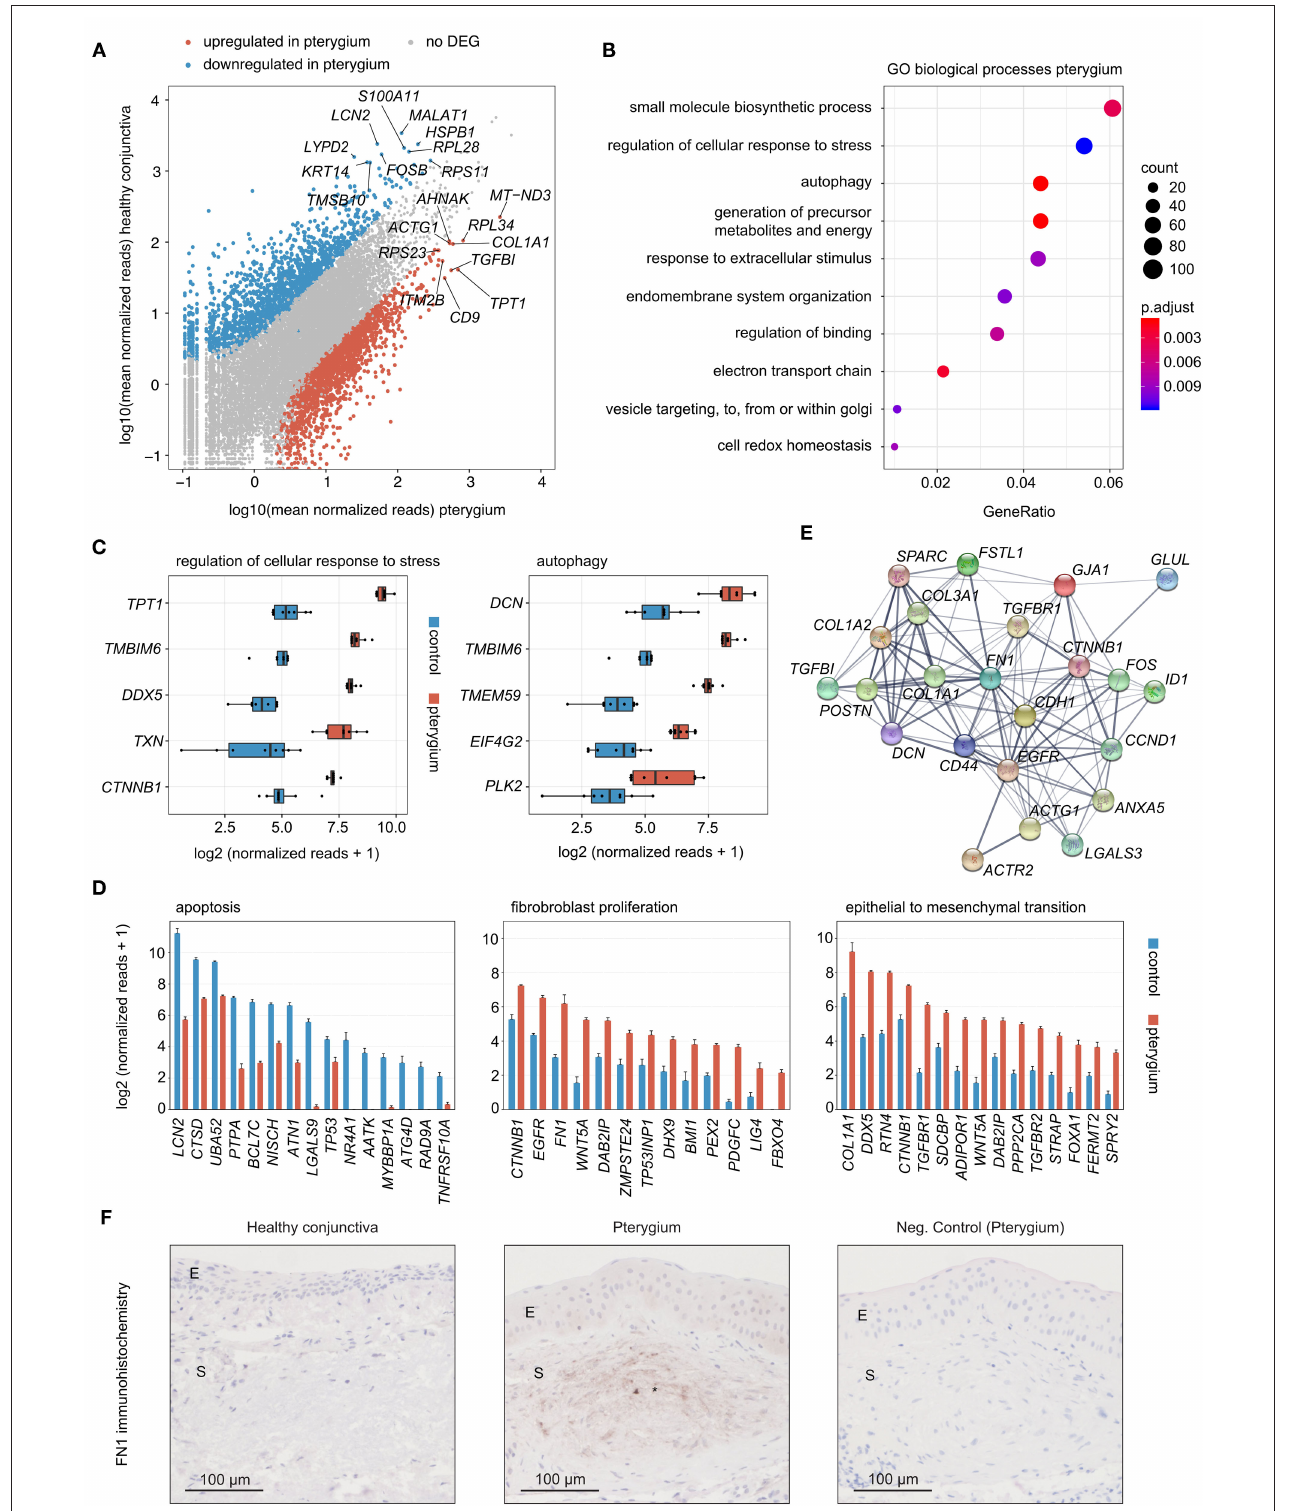
FIGURE 3 | (A) Read plot visualizing DEG in pterygia and healthy conjunctiva. The top 10 highest expressed DEG of both groups are labeled. (B) Gene ontology (GO) analysis of the upregulated genes in pterygia. The top ten biological processes, which the DEG were involved in, are shown in the dot plot. The size of the dots represents the number of associated genes (count). The adjusted p -value of each GO term is shown by color. The gene ratio describes the ratio of the count to the number of all DEG. (C) Box plots illustrating normalized reads of the top five expressed factors of two disease-relevant GO terms. (D) Bar plots visualizing